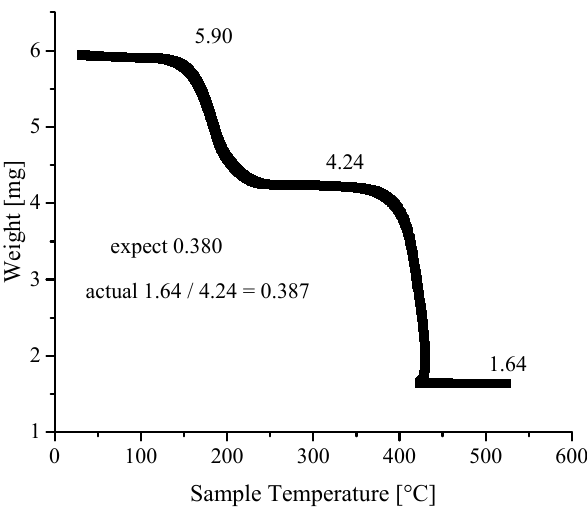
Figure 23. TGA scan in air for neat clean crystals of Ni-BpyNH2. Loss of guest DMSO is complete by 250 °C yielding the guest-free framework. The “expected” value on the plot is the expected ratio of the mass of residual NiO to the mass of the guest-free framework as determined from the structure determined by single-crystal X-ray diffraction, whereas the “actual” ratio is the experimentally determined value taken at the indicated points in the scan. See Experimental Section for an explanation of how the ratio is calculated.